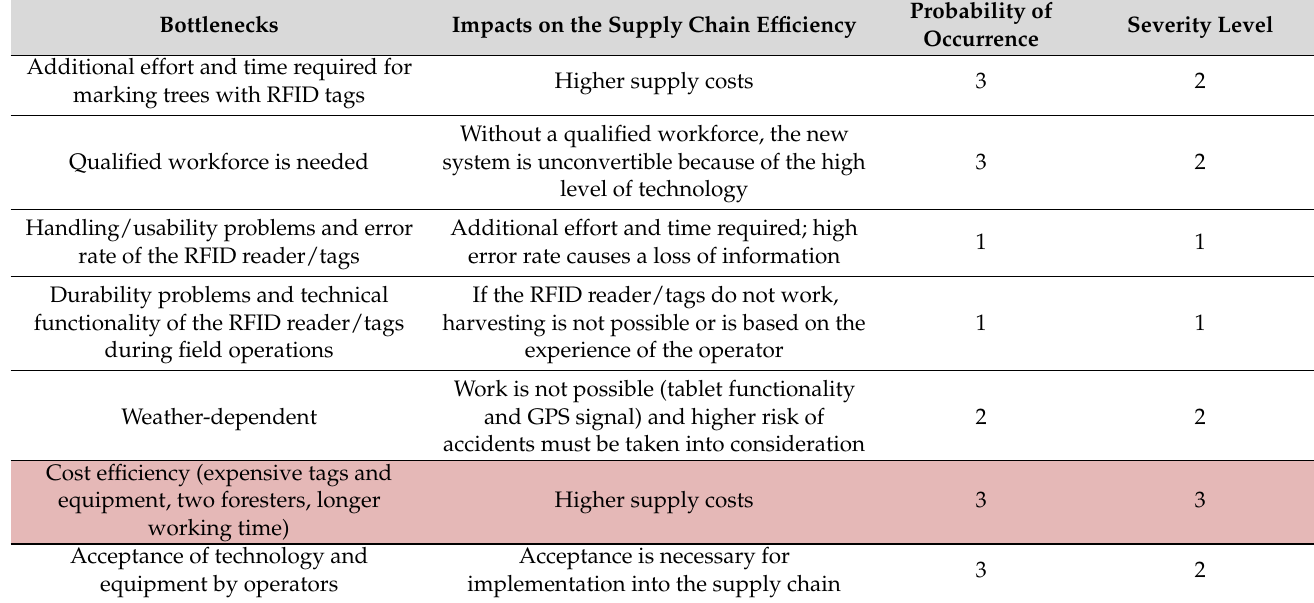
Table 5. Bottleneck and risk analysis of the RFID tree marking operation. Scale classes: low (1), moderate (2), and high (3). Bottlenecks with a high probability of occurrence and a high severity level are marked in red.